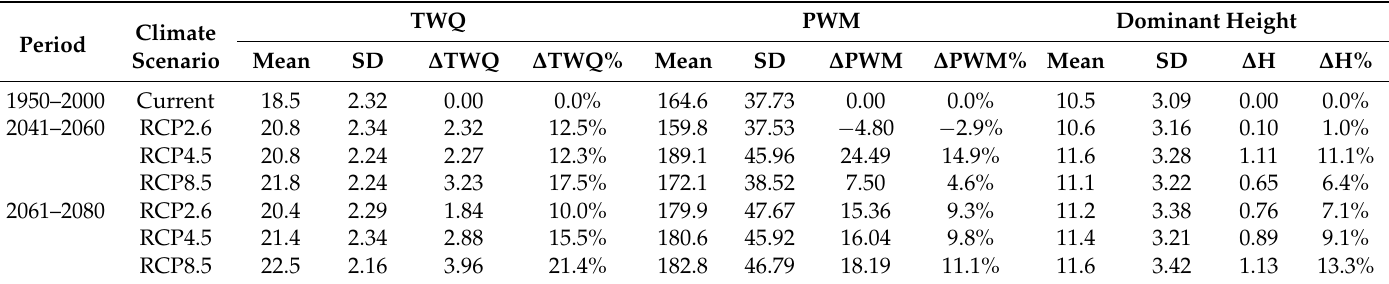
Table 3. Predicted dominant height under future climate scenarios for all